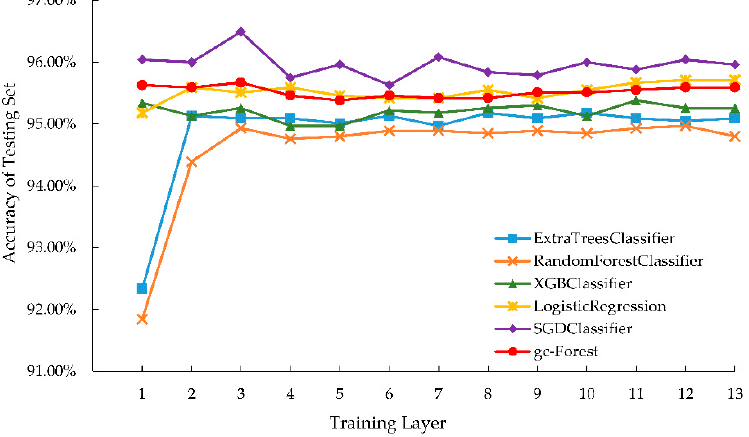
Figure 12. Test set classification accuracy of gcForest and its built-in classifiers in each layer.